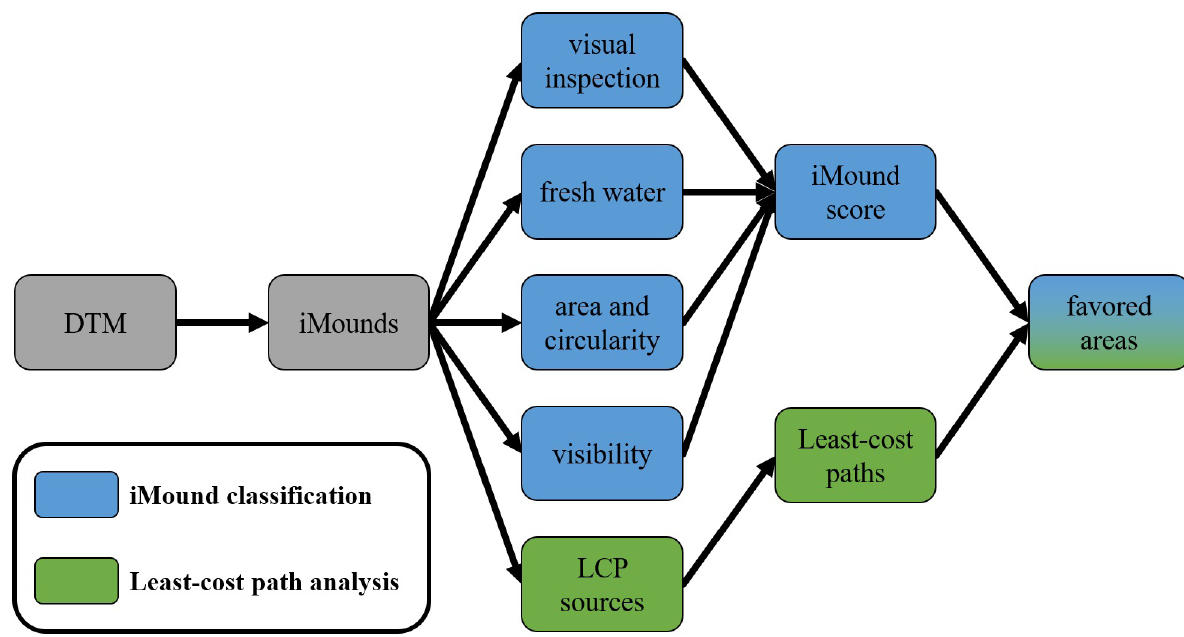
Figure 4: Workflow of the data evaluation by spatial